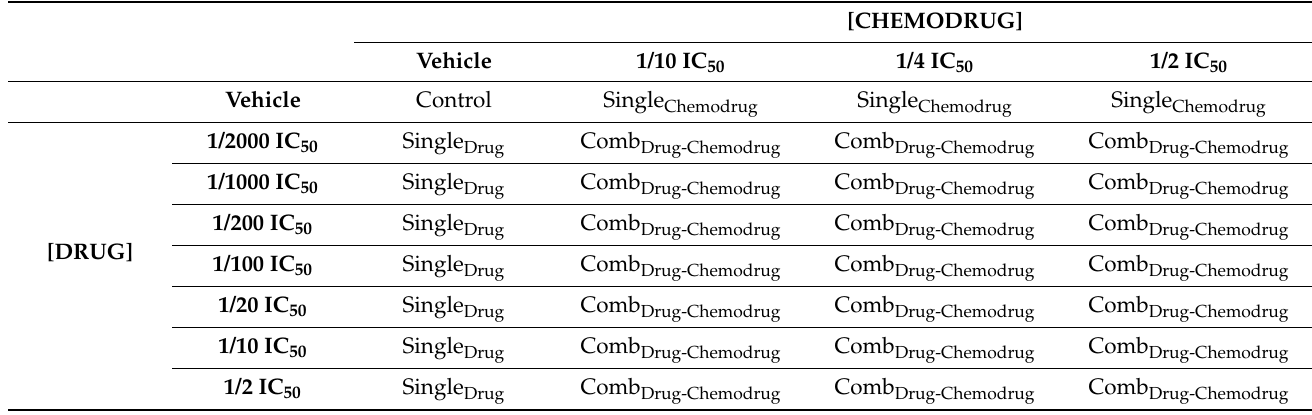
Table 2. Experimental design of the combination studies. [CHEMODRUG] refers to the concentrations of chemotherapeutic drugs (DTIC and TMZ) and [DRUG] refers to all the COX and LOX concentrations tested in combination. IC 50 values for the drugs were the ones obtained in the SRB assay at 24 h and IC 50 values for the chemotherapeutic drugs were the ones obtained at 72